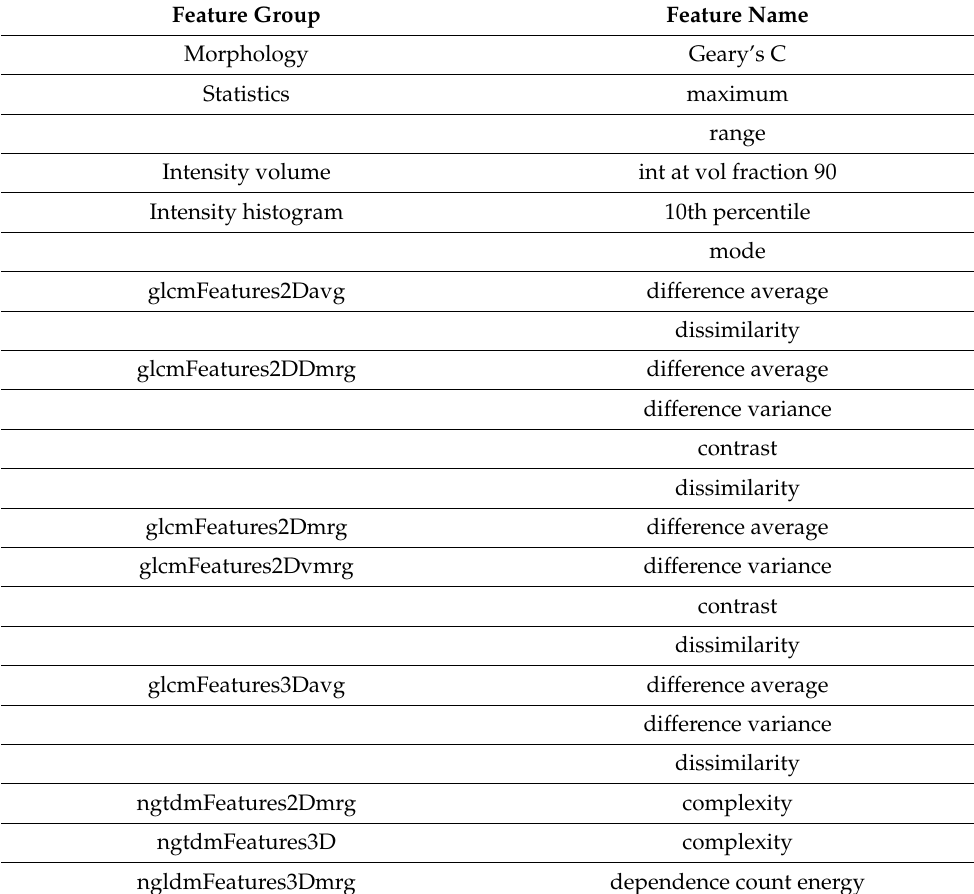
Table 2. Texture features that are sensitive mainly to tissue near outer annular